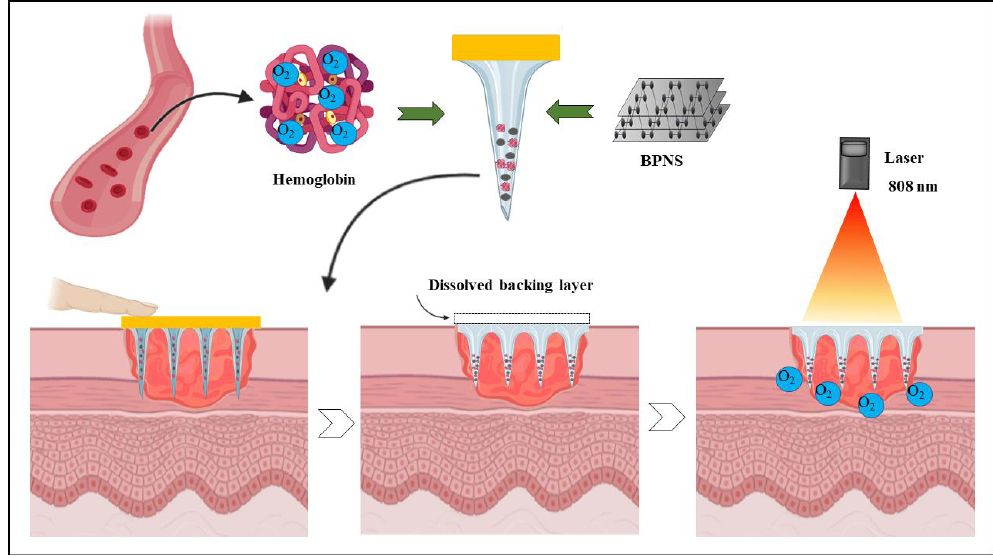
Figure 8. Schematic representation enumerating Near infrared region (NIR)-mediated controlled release of O 2 for wound healing using microneedles encapsulating BPNS and Hb.